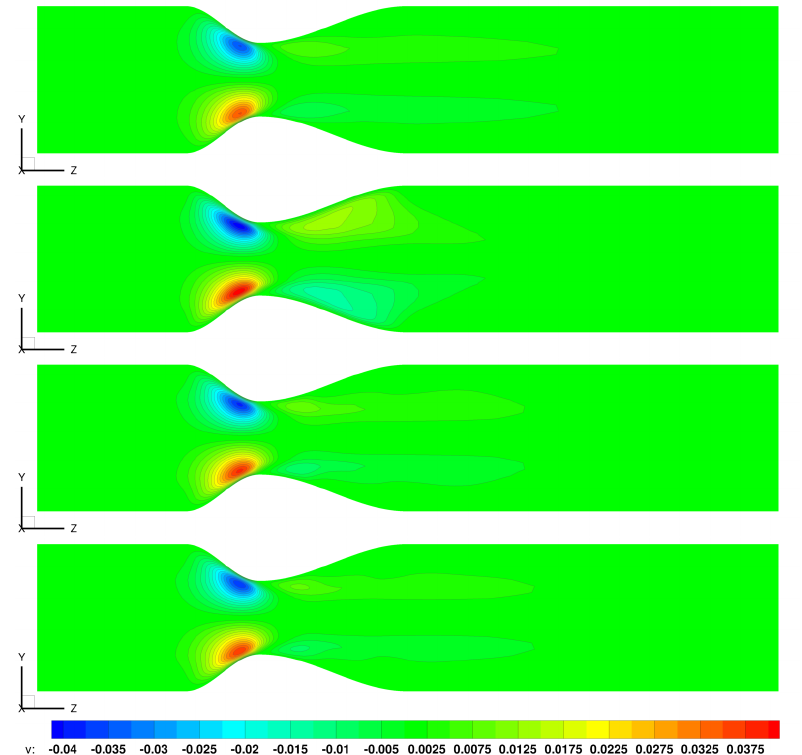
Figure 19. Radial velocity at flow rate Q = 1.0 cm 3 /s—GOB (top figure) and Johnson–Segalman models for a = − 0.9, a = − 0.8, a = − 0.7 (from the top).